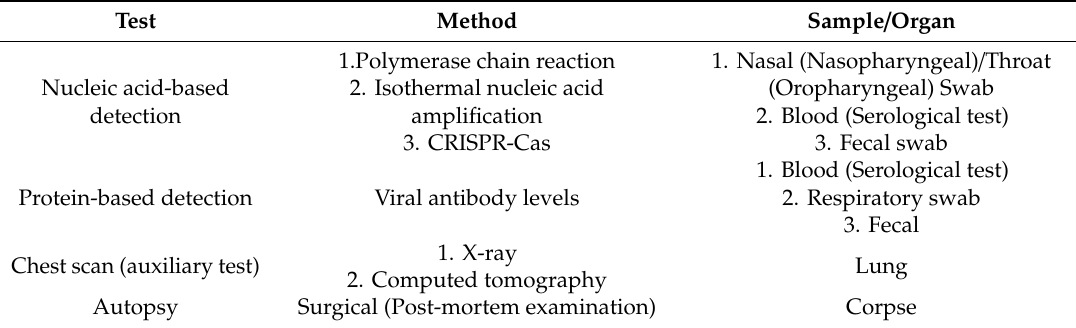
Table 1. Various detection methods implied for COVID-19